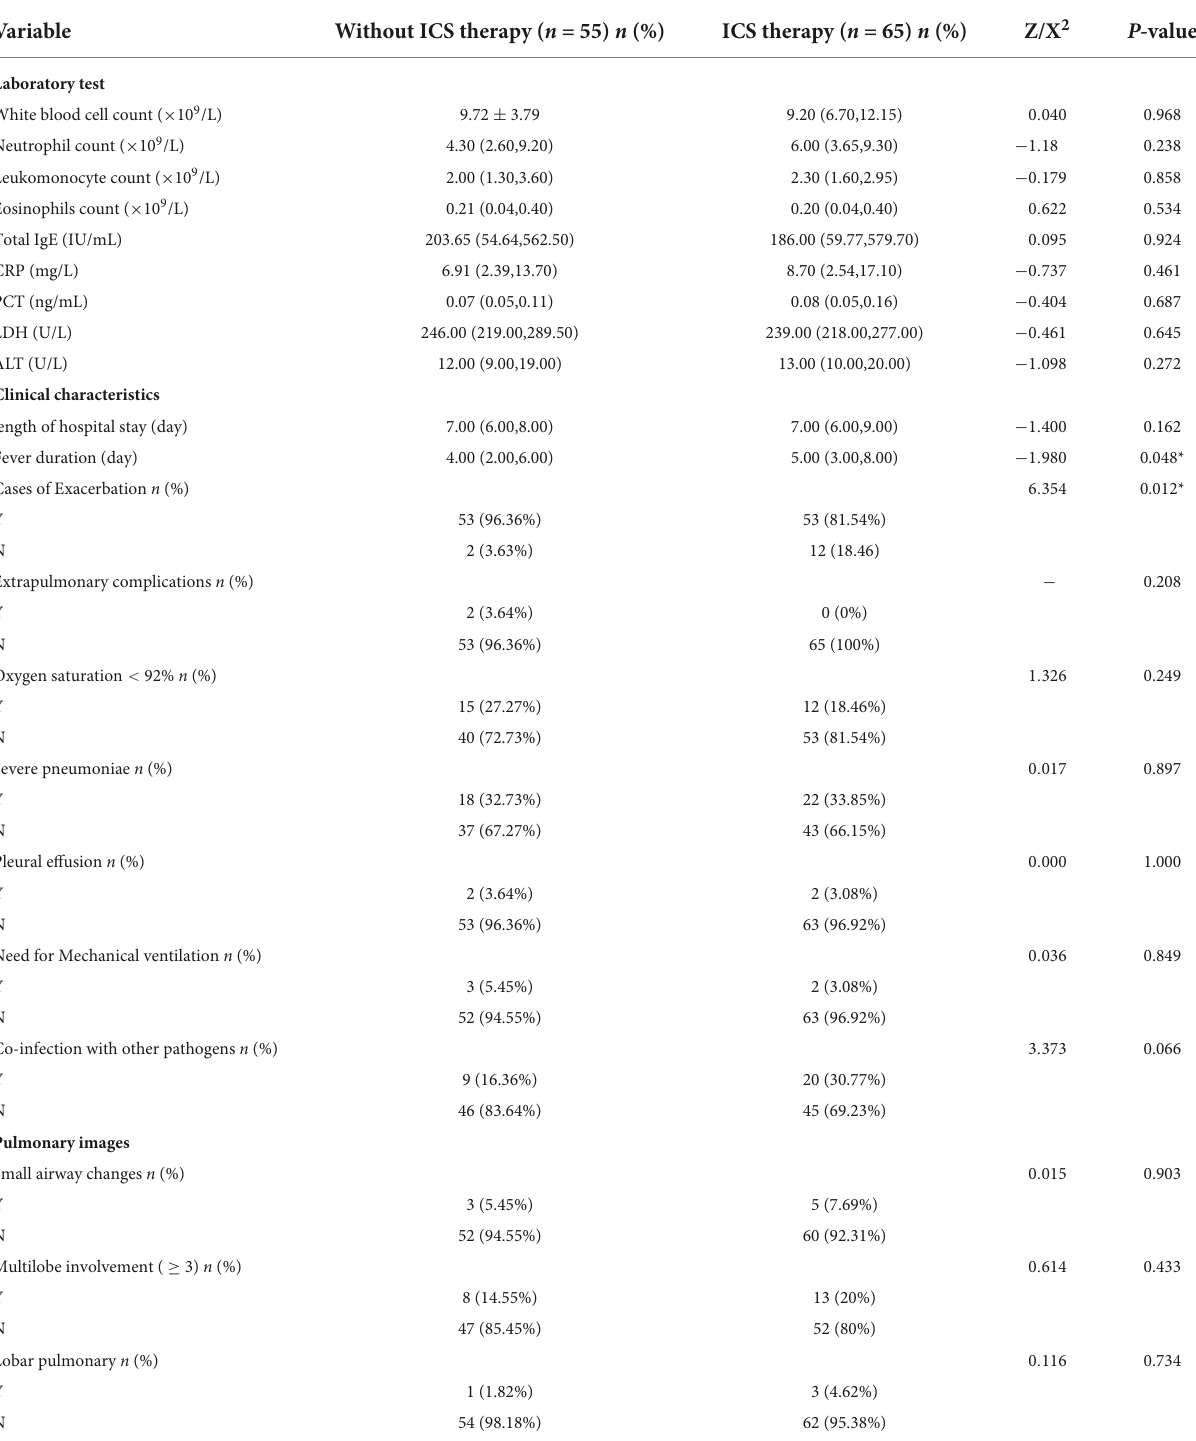
TABLE 5 Clinical characteristics of children with MPP with